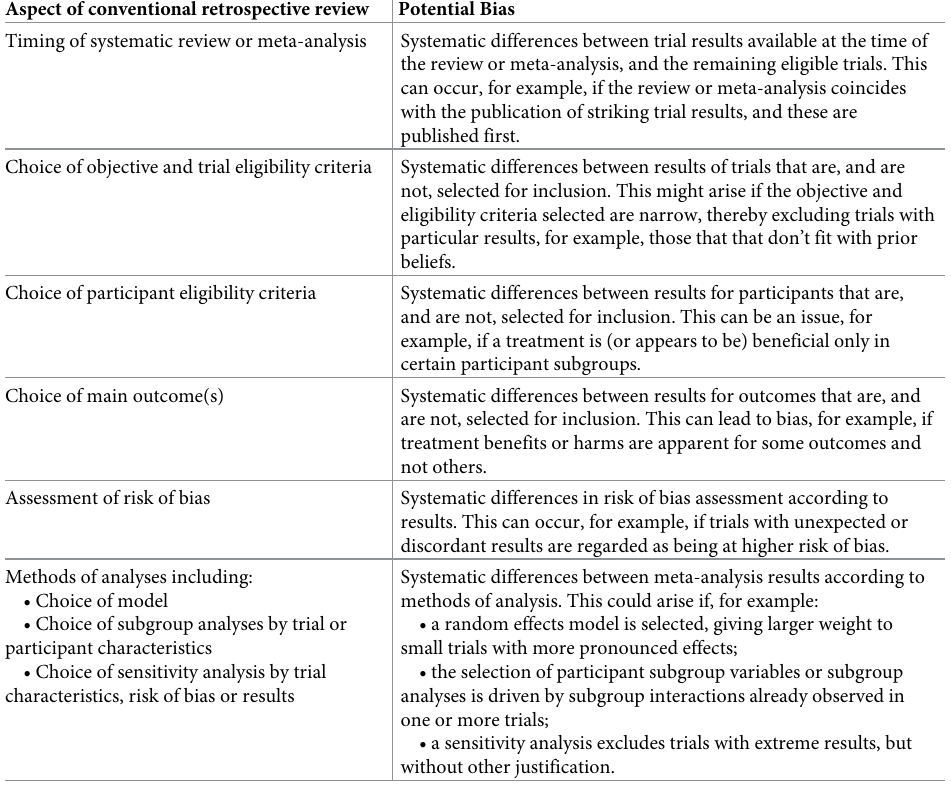
Table 1. Aspects of conventional, retrospective systematic reviews and meta-analyses that can be biased by prior knowledge of trial results. Aspect of conventional retrospective